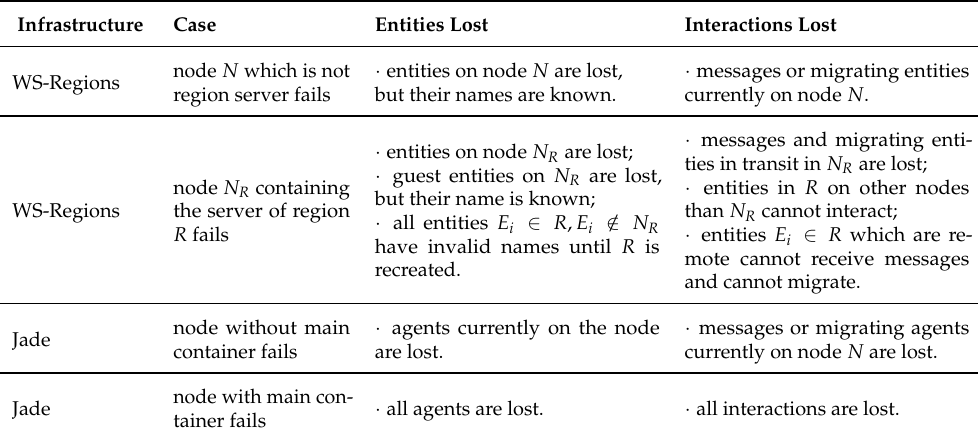
Table 4. A qualitative analysis of the robustness of the WS-Regions Protocol compared to Jade for cases when a node fails